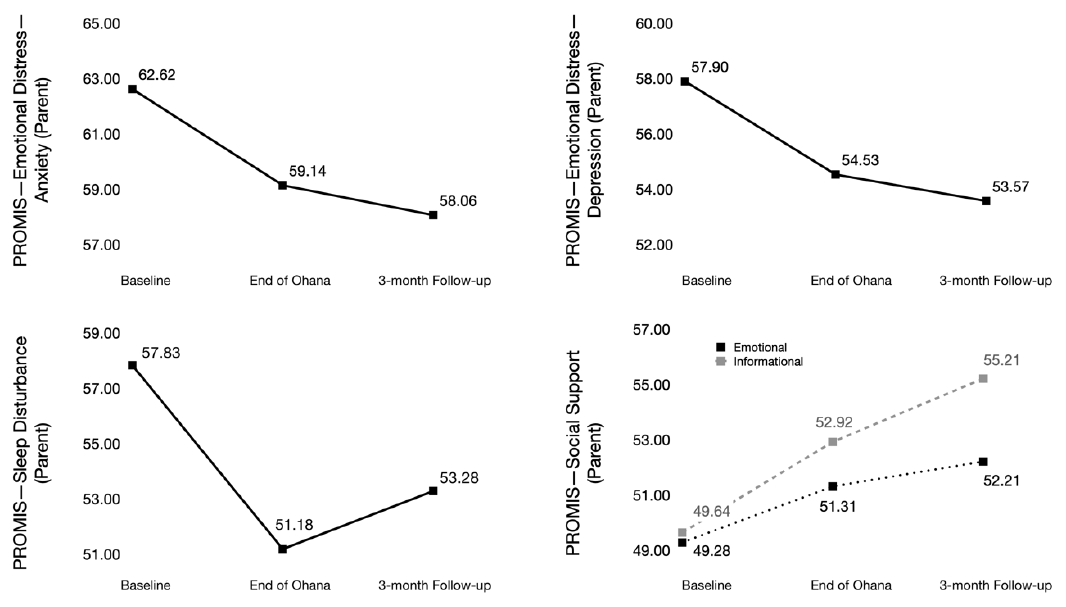
Figure 3. Changes in T-scores for exploratory outcomes for parents. PROMIS: the Patient-Reported Outcome System.